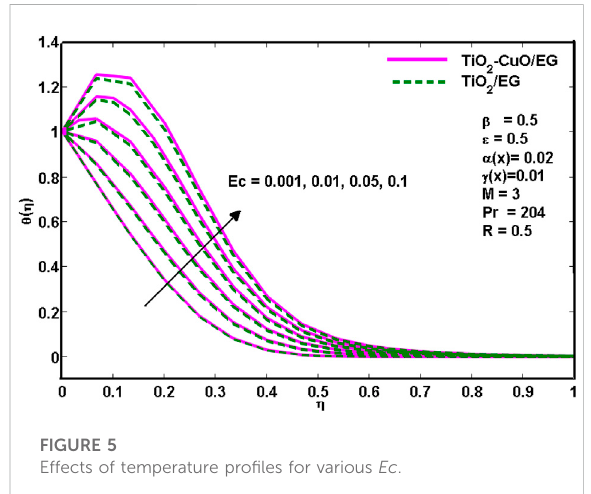
FIGURE 5 Effects of temperature pro fi les for various Ec .